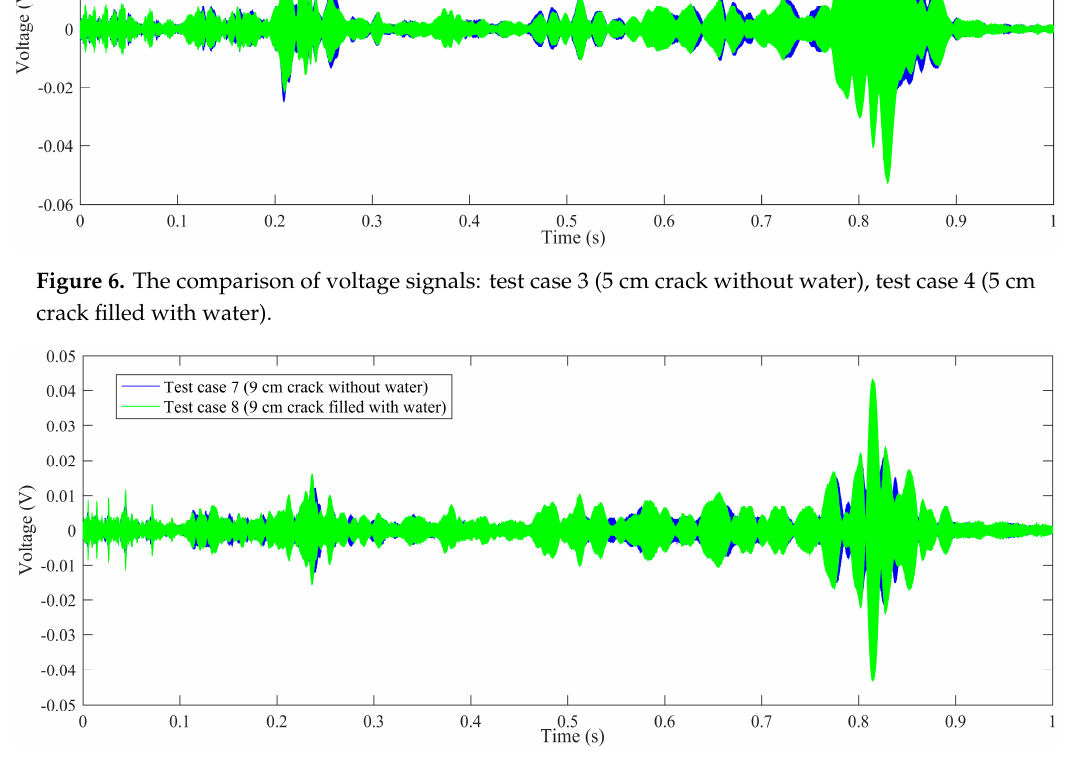
Figure 6. The comparison of voltage signals: test case 3 (5 cm crack without water), test case 4 (5 cm crack filled with water).